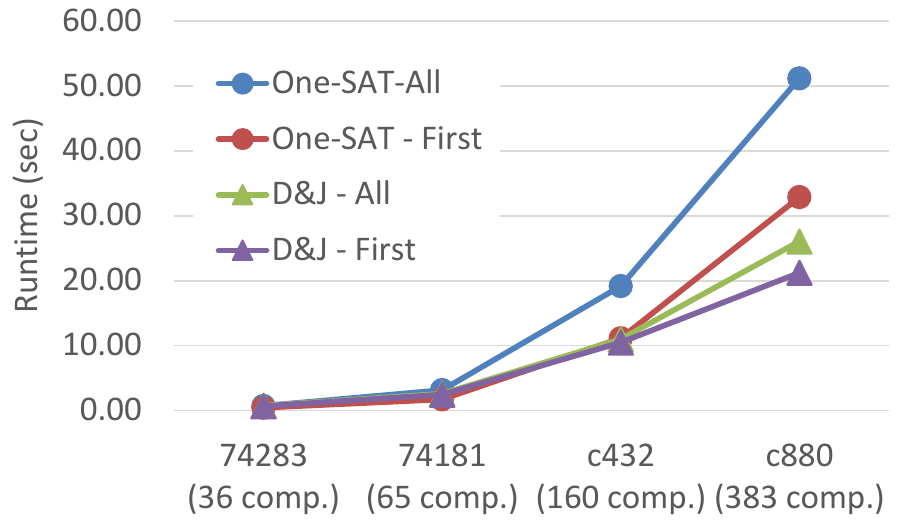
Figure 3. Runtime as a function of the system’s